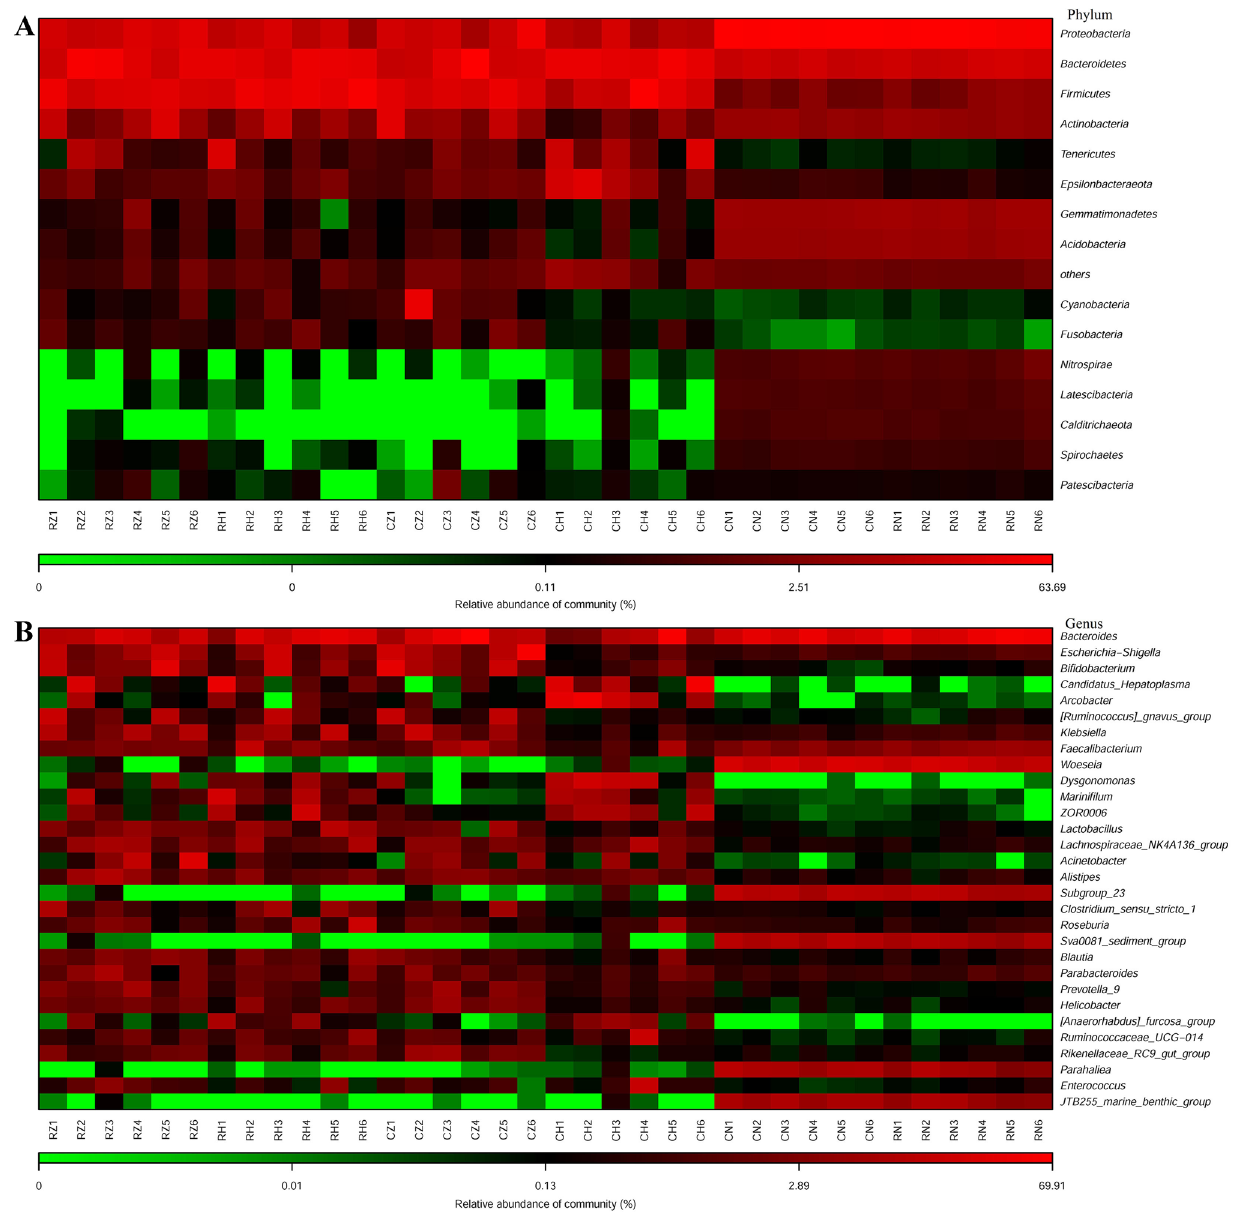
Figure 4. The composition of all groups at phylum ( A ) and genus level ( B ).